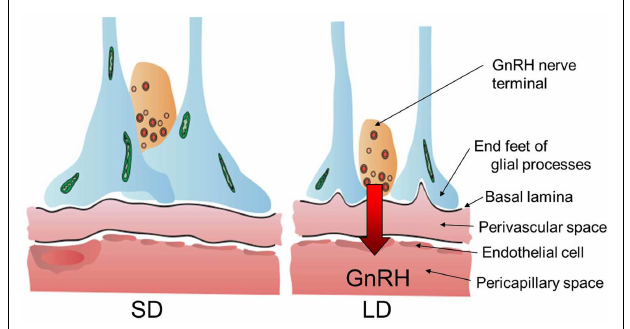
FIGURE 3 | Neuro–glial interaction between GnRH nerve terminals and glial endfeet . Locally activated thyroid hormone within the MBH regulates neuro–glial interaction in the median eminence and these morphological changes appear to regulate or modulate seasonal GnRH secretion from the hypothalamus to portal capillary.The illustration has been modified from that published byYoshimura